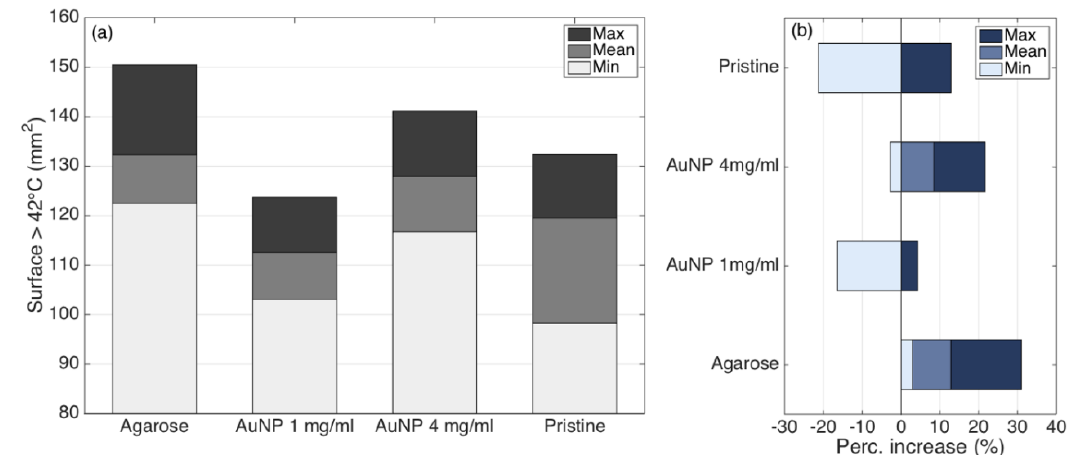
Figure 13. Quantification of the thermal damage region (temperature >60 °C) for each experimental condition. ( a ) Evaluation of the surface exposed to temperature exceeding 60 °C at the maximum ablation temperature; bar charts show the maximum (dark), minimum (bright), and mean (interme- diate) values of the areas, over four experiments for each RFA condition. ( b ) Percentual increase or decrease for the ablated surface, with respect to the reference condition (pristine RFA, mean surface).